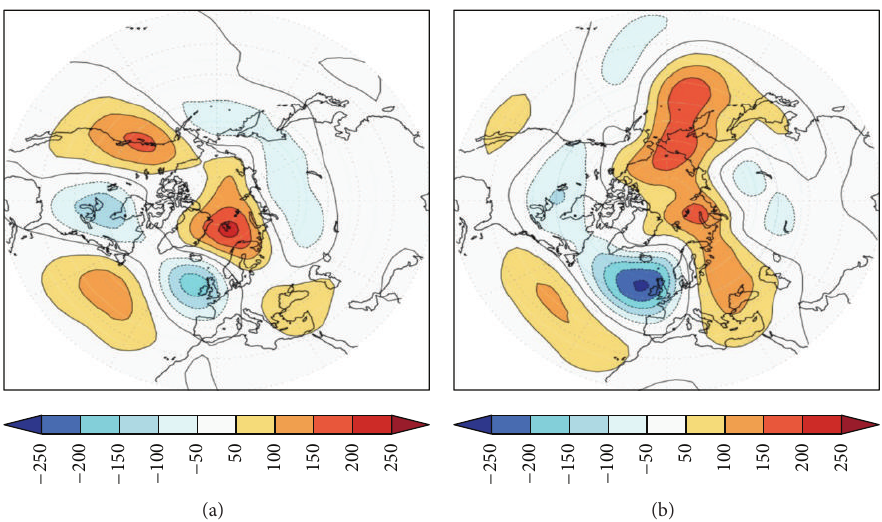
Figure 1: (a) January 2014 geopotential height anomalies in (m). (b) February 2014 geopotential height anomalies.